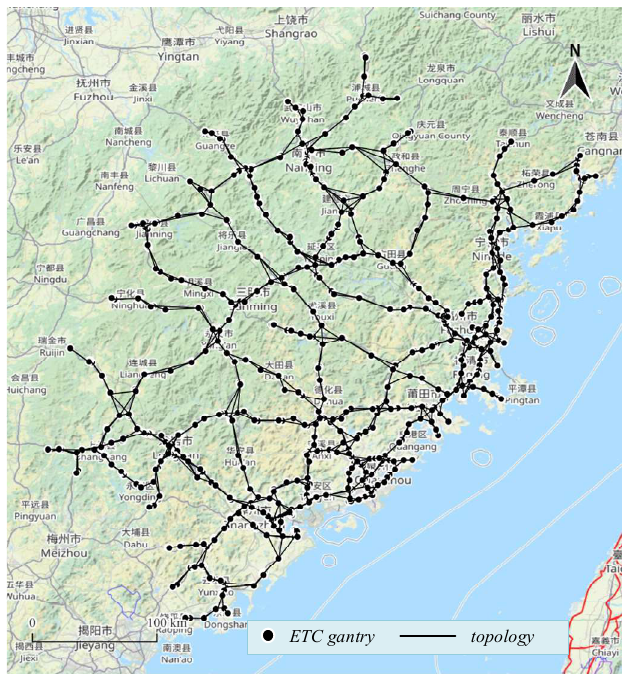
Table 1. Description of Partial A(cid:308)ributes in ETC Transaction Data.